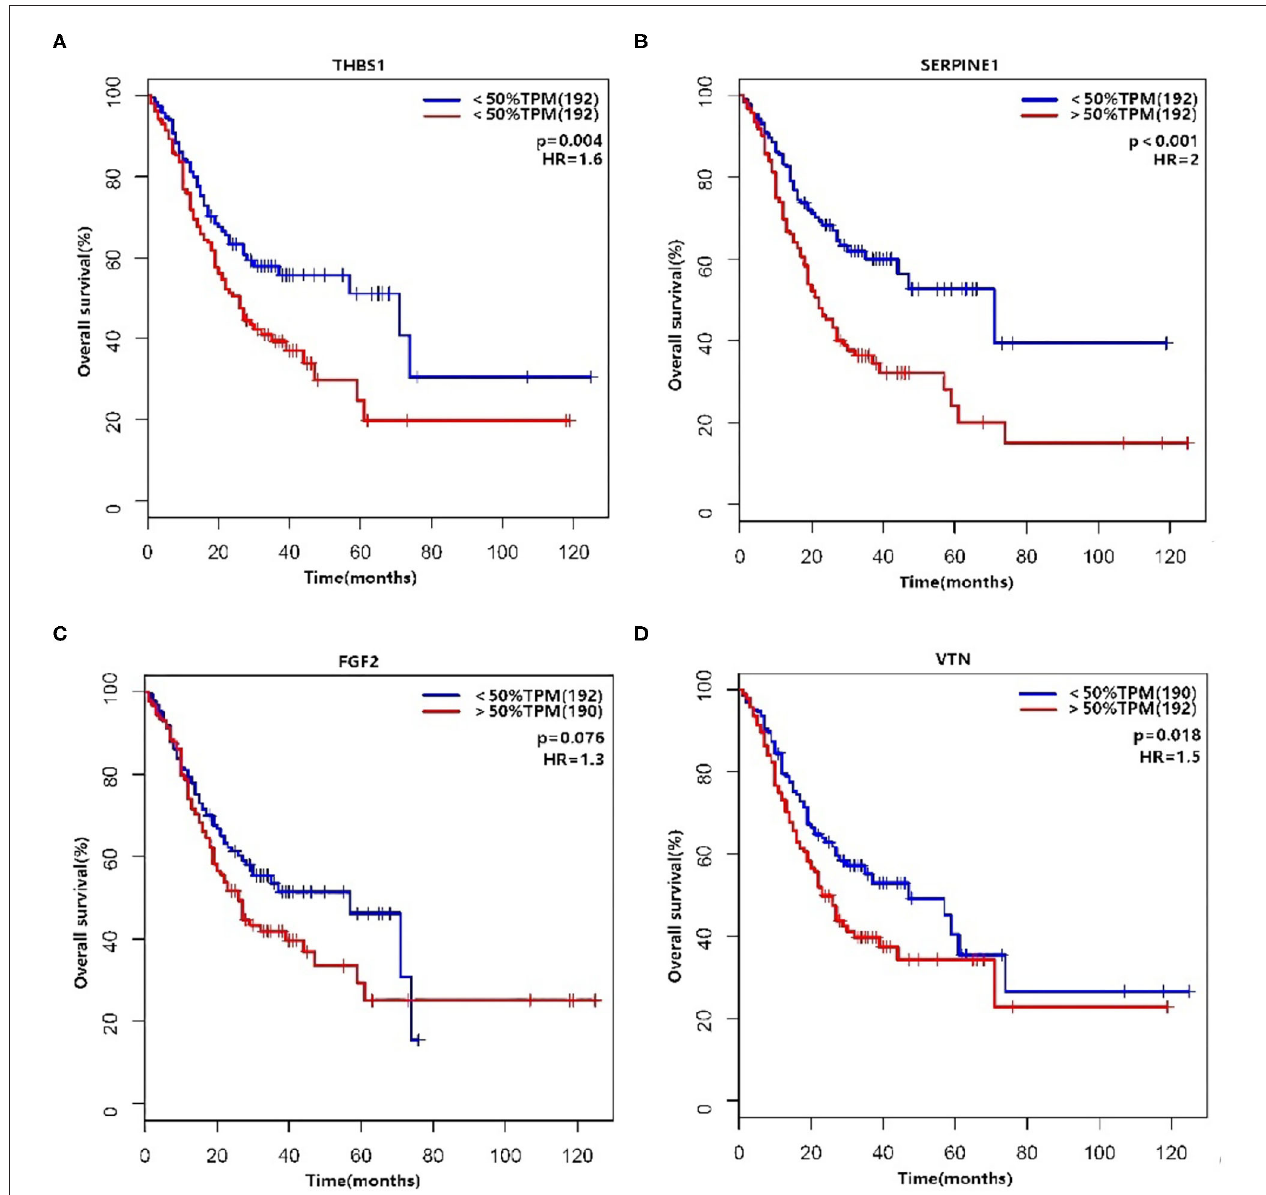
FIGURE 6 | Survival analysis are shown for (A) THBS1, (B) SERPINE1, (C) FGF2, and (D)